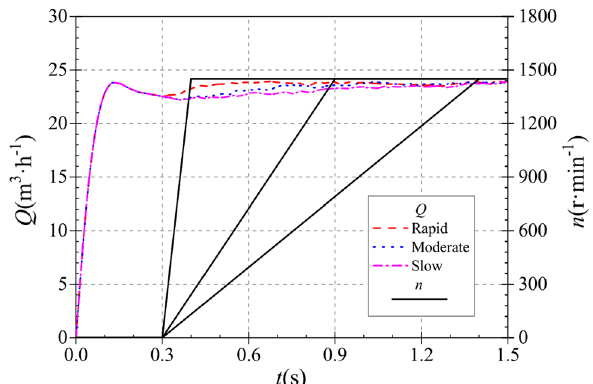
Figure 7. Instantaneous flow rate rise characteristics.